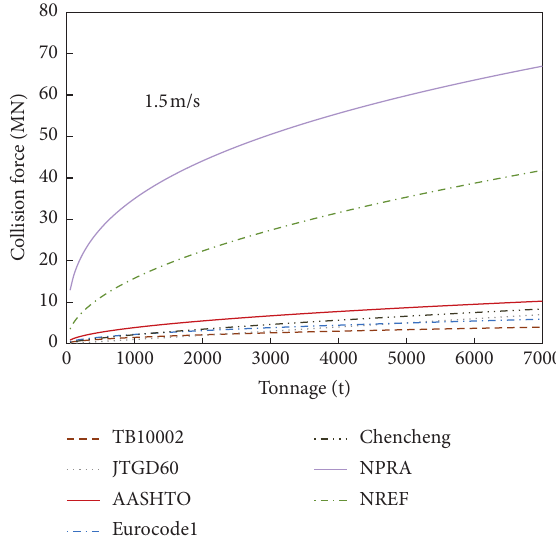
Figure 5: Comparison of relationships between ship impact force and ship impact tonnage for various models.